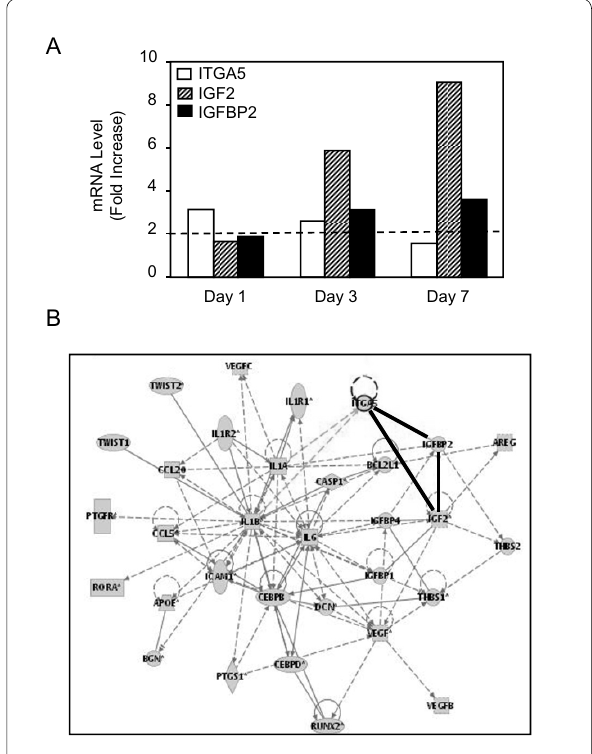
Figure 1 IGF2 and IGFBP2 Expression is Up-regulated During Os- teoblast Differentiation of hMSCs . Adult hMSCs were treated with or without dexamethasone (10 -7 M) to induce osteoblastic differentiation. Total RNA was collected from three different donors and used for mi- croarray hybridization. Data were normalized and genes that were up- regulated (fold change >2) in dexamethasone-treated compared to untreated MSCs were subselected (A) . Analysis of gene network using Ingenuity Software indicated interactions between IGF2, IGFBP2 and ITGA5 (B)